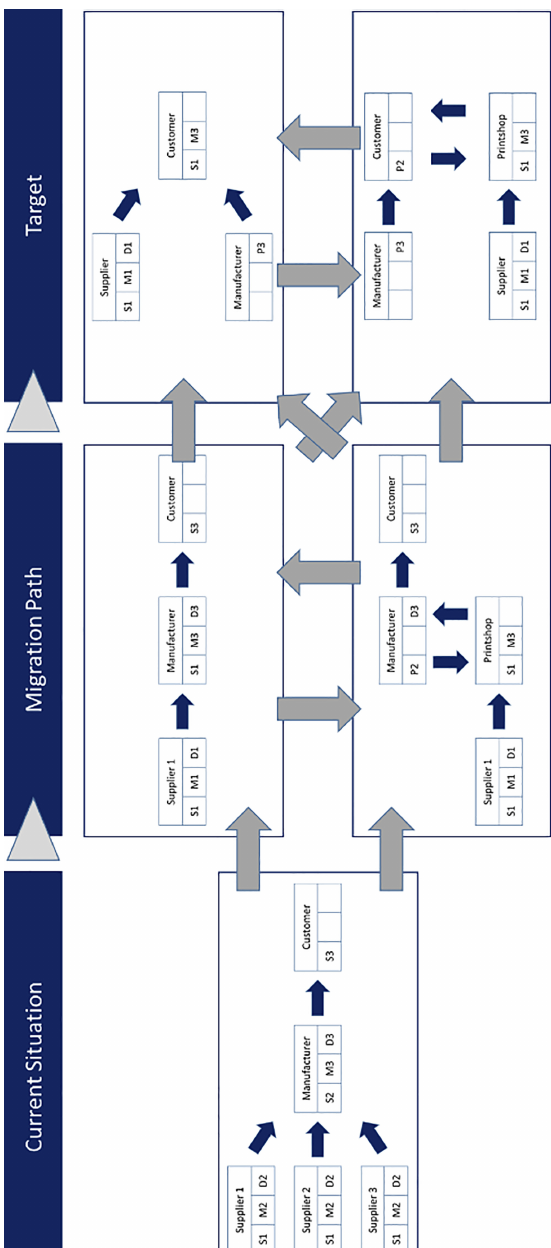
Figure 6. Migration of supply chains under the influence of 3D printing. It results in the reduction and streamlining of supply chains and thus in a modification of work- applied